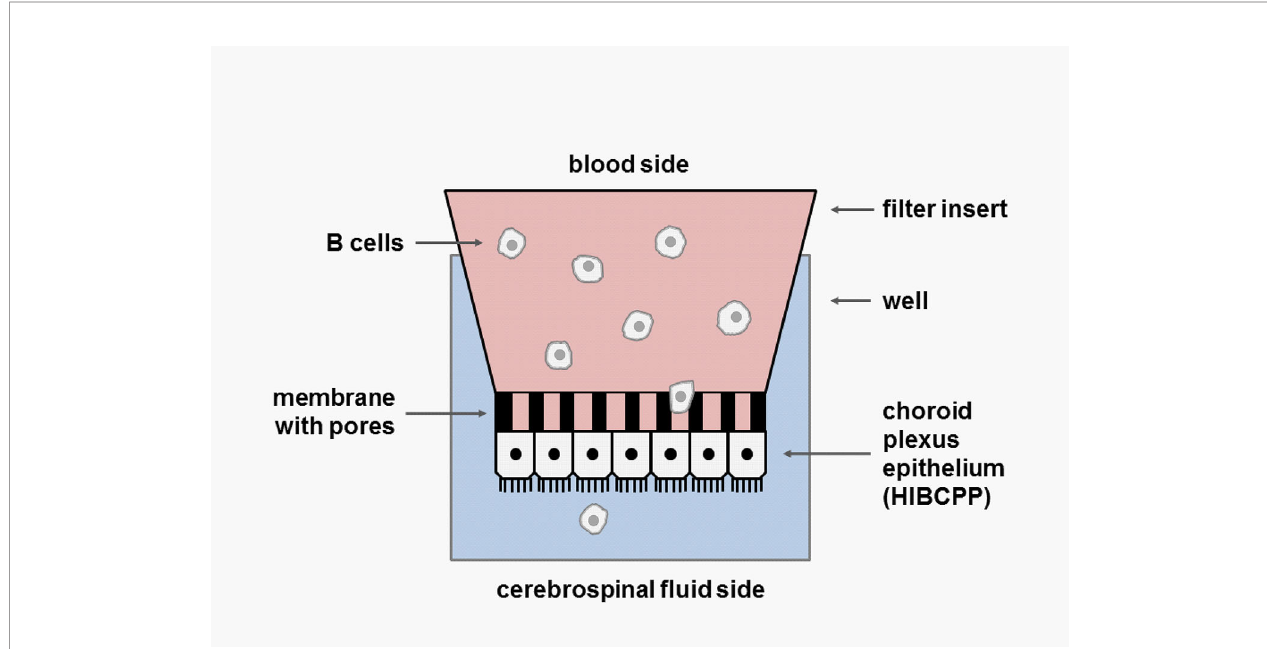
FIGURE 1 | Inverted transwell culture system. Inverted culture of HIBCPP cells on the bottom side of a transwell fi lter of 5 µm pore size. The upper (basolateral) side represents the lumen of the blood capillary, while the lower (apical) side mimics the CSF space. B cells are added to the upper compartment (blood side) and a cocktail of B-cell chemoattractants to the lower compartment. After 4 h transmigration (TM), fi lters are transferred onto a fresh plate; migrated cells are collected from the lower chamber and quanti fi ed by FACS. A chemotactic index (CI) is calculated for each B-cell